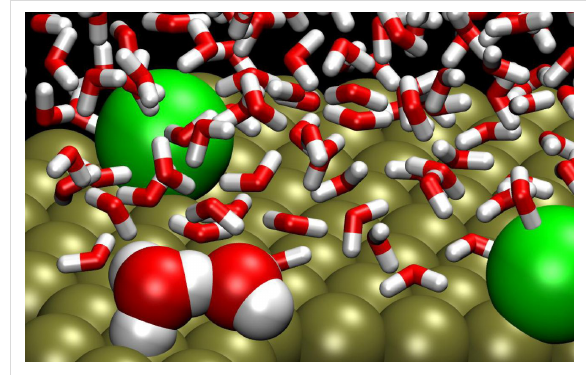
Figure 1: Snapshot for a water film with two adsorbed Cl − ions (green).